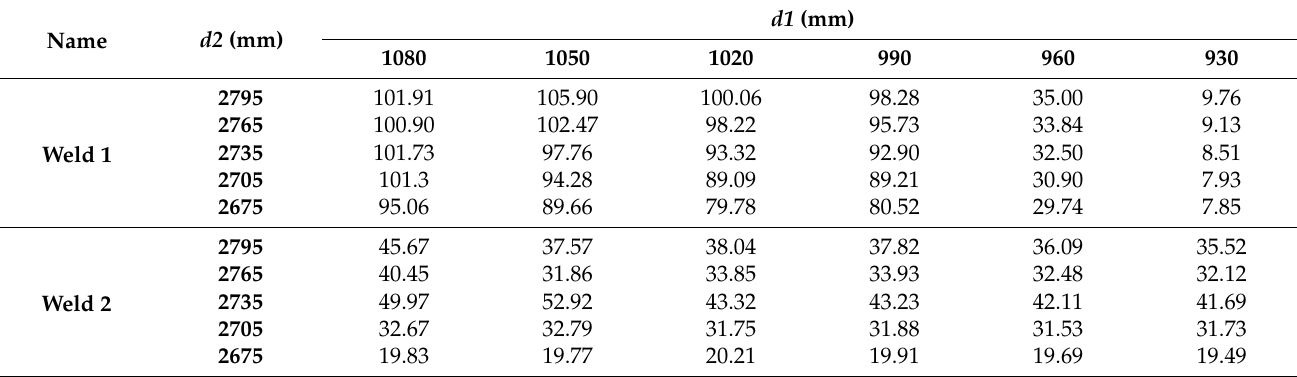
Table 3. The stress value at intersection point